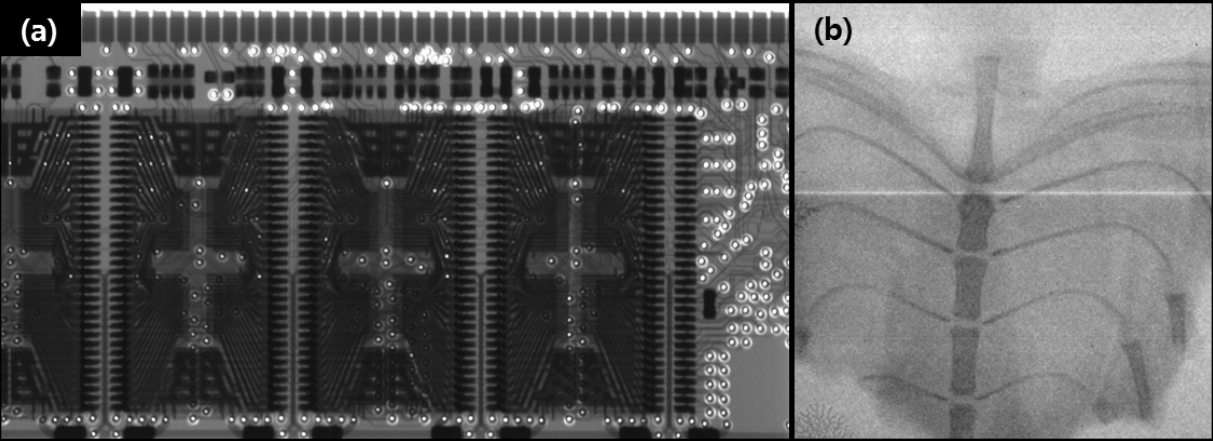
Figure 6. X-ray images of ( a ) dynamic random-access memory; ( b ) chest region of